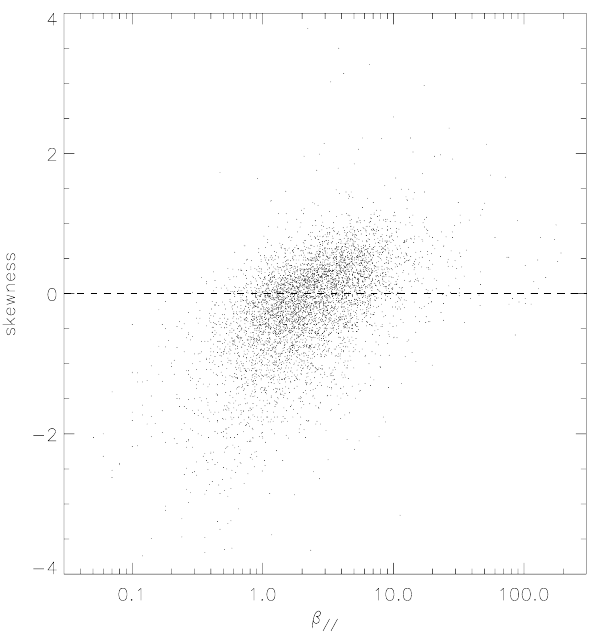
Fig. 3. Skewness as a function of β k for all mirror events detected in the period 1 February 2001–31 December